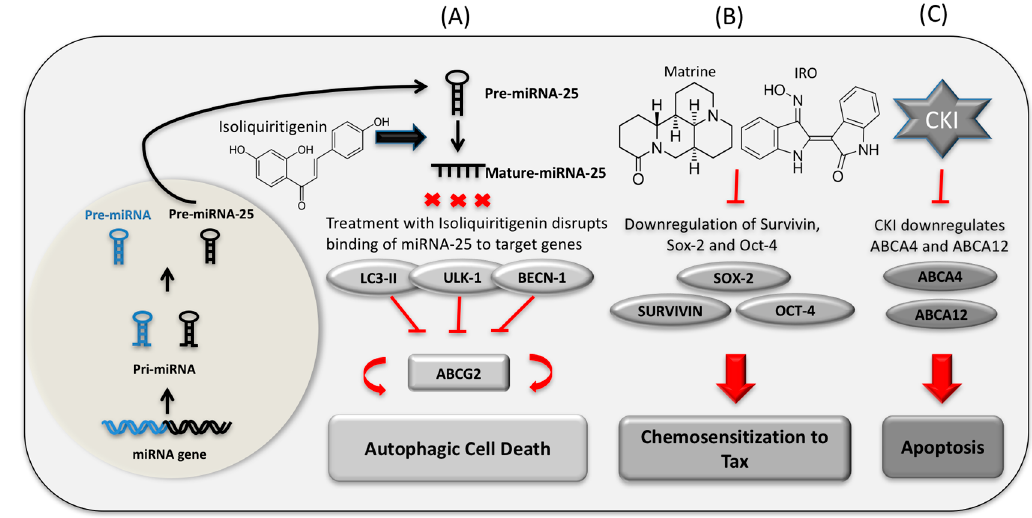
Figure 2. Three panels ( A – C ) show the influence of natural compounds on gene expression in terms of MDR regulation. ( A ) Treatment of Isoliquiritigenin blocks binding of autophagy-related miR-25 to the 3 ′ UTR region of ULK-1 , LC3-II , and BECN-1 in killing drug-resistant breast cancer cells [133]; ( B ) Matrine and indirubin-3 ′ -monoxime (IRO) reverse chemoresistance of paclitaxel (TAX) by downregulating the expression of Sox-2, Survivin, and Oct-4 proteins in human squamous cell carcinoma [134]; ( C ) CKI suppresses the expression of the drug resistant related genes ABCA12 and ABCA4 in cancer cell apoptosis. The involvement of miRNAs in the regulation of these genes with respect to drug resistance has not yet been confirmed [87].